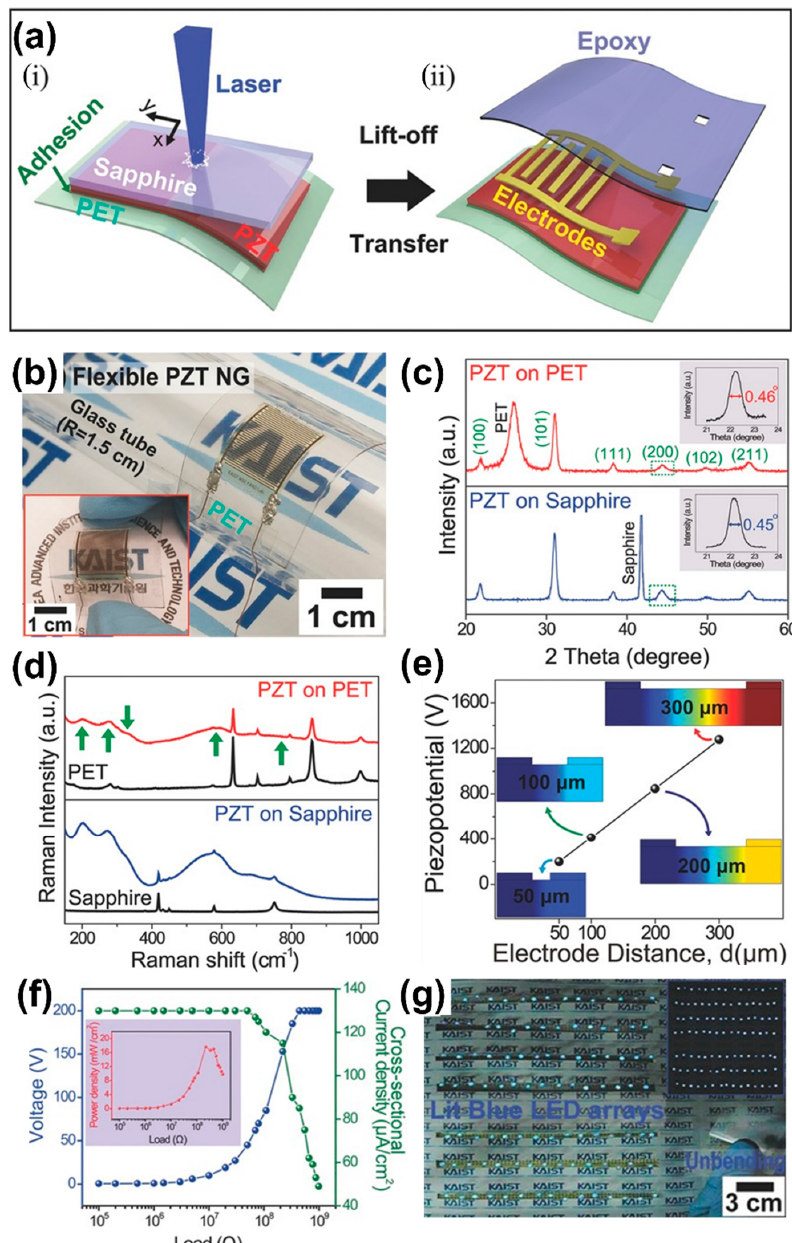
Figure 7. ( a ) Schematic illustration of the fabrication process of PZT thin film harvester by LLO process. ( a - i ) PZT thin on transparent sapphire substrate film was transferred onto PET substrate by laser irradiation. ( a - ii ) Interdigitated electrodes and a protective layer were coated on PZT thin film for the fabrication of the harvesting device. ( b ) Flexible PZT thin film harvester attached to a glass tube and bent by fingers (inset). ( c ) X-ray diffraction patterns of PZT thin films on sapphire and flexible PET substrate. Magnified view of X-ray diffraction of (200) peak (inset). ( d ) Piezo-potential in PZT film with different electrode distances calculated by the simulation model. ( e ) The calculated piezo-potential in the PZT thin film varied with the distance between adjacent electrodes and increased linearly with an inter-electrode gap on the PZT film. ( f ) The generated voltage and cross-sectional current density of PZT generator as a function of load resistance from 2 k Ω to 1 G Ω . Output power versus load resistance (inset). ( g ) Photograph shows 105 lighted LEDs when the PZT film harvester was unbent by the human finger and driven LEDs in a dark room (inset). Reproduced with permission [26].